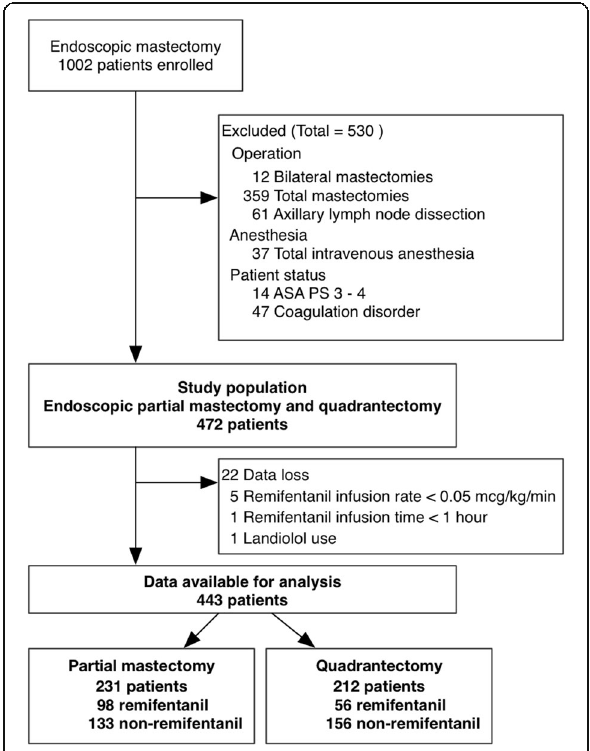
Fig. 1 Flowchart of enrolment. A total of 1002 patients underwent mastectomies between August 2005 and June 2010. Initial screening excluded 530 patients by evaluating suitability for operation, anesthesia, and patient-related factors. Secondary screening excluded additional patients because of unreliable